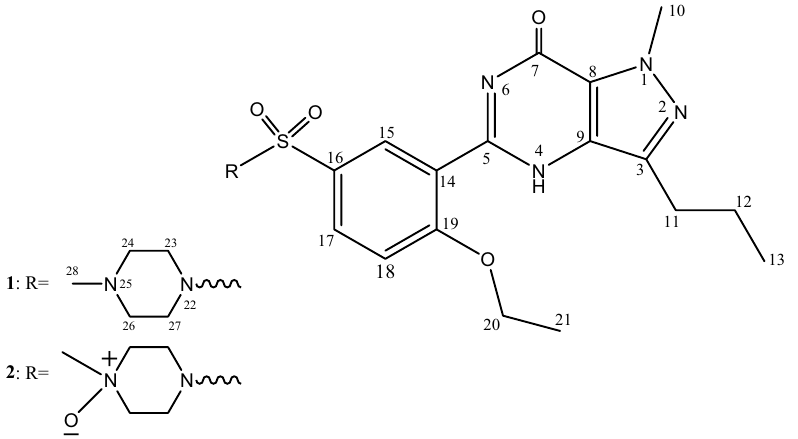
Figure 1. Structures of Sildenafil (SLD) and Sildenafil N-oxide (SLD